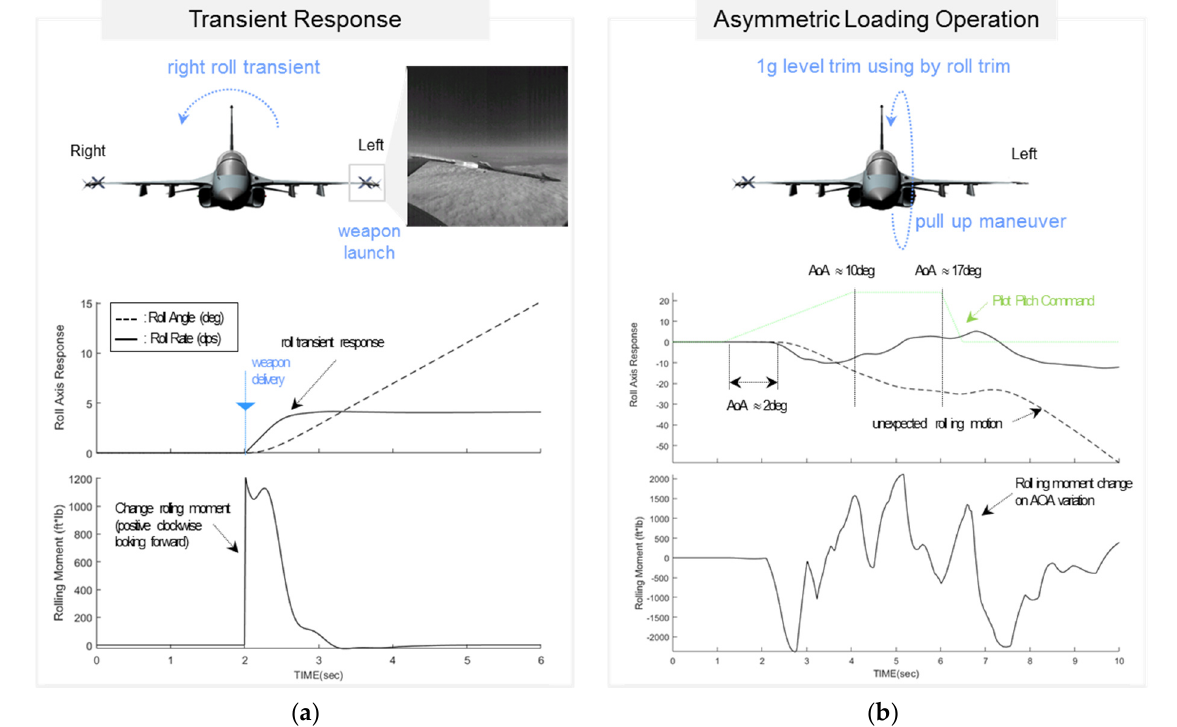
Figure 1. Definition of unexpected response for weapon launches and asymmetric store configurations ( a ) transient due to weapon launch, ( b ) unexpected rolling motion for pull up maneuver of asymmetric store configuration.